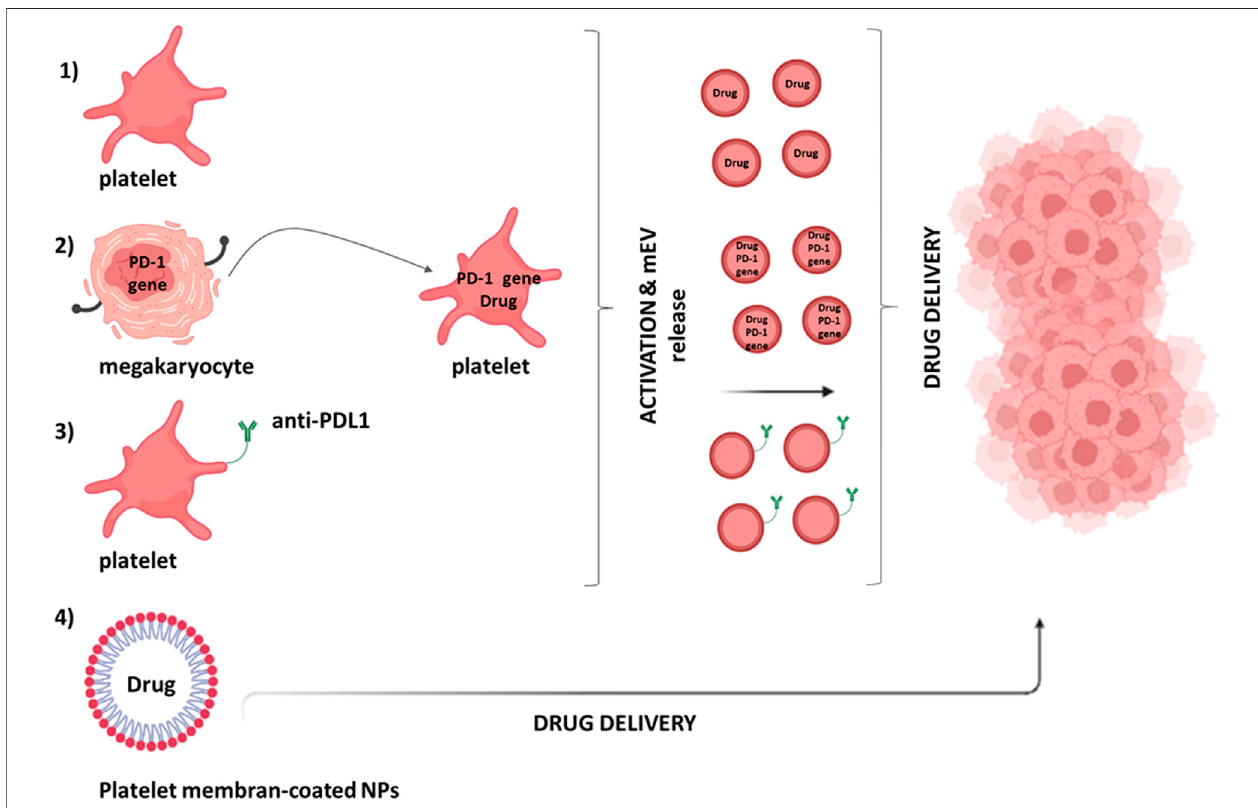
FIGURE 5 | Platelet ’ s contribution in drug delivery systems. Different approaches can be used to deliver drugs to the tumor microenvironment by platelets: (1) platelets can be loaded with the anticancer drug via the open canalicular system; (2) genetically modi fi ed megakaryocytes (MKs) can give rise to mature platelets expressing programmed death-1 (PD-1) [involved in the immune checkpoint PD-1/programmed death-ligand 1 (PDL-1)] that can also be loaded with the anticancer drug; (3) monoclonal antibodies against PDL-1 (aPDL1) can be covalently bound to resting platelets; (4) melanin nanoparticles (MNPs) can be coated with platelet